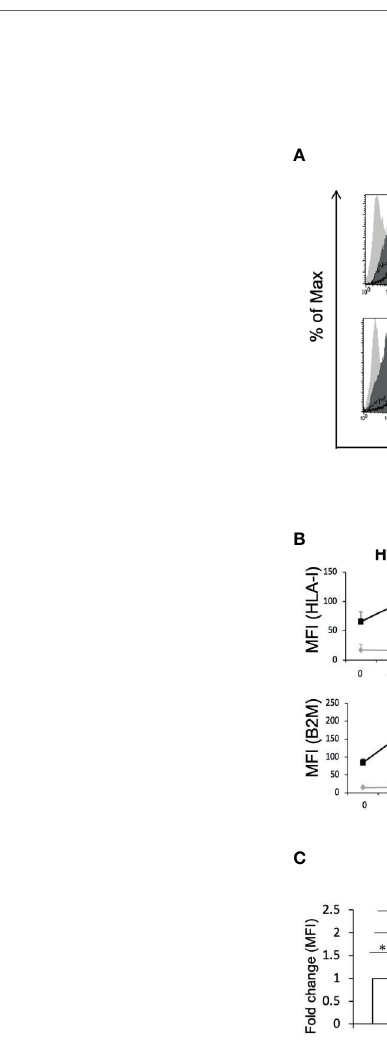
FIGURE 1 | Regorafenib induces expression of cell surface HLA-I molecules in liver cancer cell lines in the presence of IFN g . (A) The indicated cell lines were treated with vehicle (DMSO, dark gray fi lled), IFN g (1 ng/mL) alone (black line, un fi lled), or IFN g plus 5 m M regorafenib (black dotted line). Cell surface HLA-I and B2M expression was analyzed by fl ow cytometry 72 hours later. Cells stained with an isotype control antibody are shown (light gray fi lled). A representative fl ow cytometry histogram is shown. (B) Cells were treated with regorafenib (5 m M) at the timepoints indicated along the x-axis with or without IFN g for 72 hours. Values represent the average mean fl uorescence intensity (MFI) from 3 independent experiments. (C) SNU398 or Huh7 cells were treated with regorafenib at increasing concentrations in the presence of IFN g for 72 hours. Values are expressed as fold change relative to cells treated with IFN g alone. Reg, regorafenib. (*: p < 0.05, **: p < 0.01, ***: p < 0.001, ****: p <